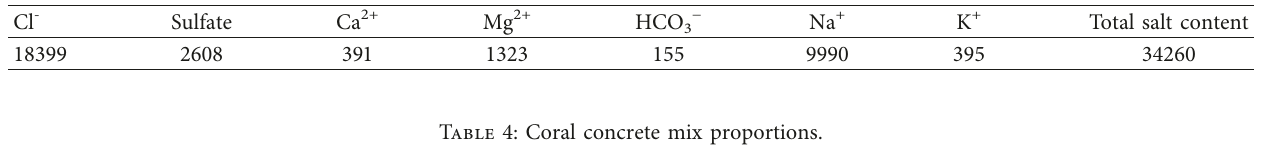
Table 3: Chemical composition of artificial seawater (mg/L).